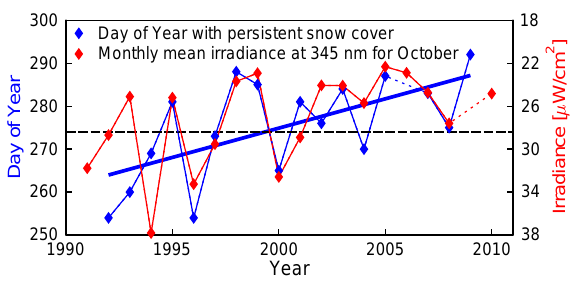
Fig. 5. Comparison of onset of snow cover and irradiance at Bar- row. Blue symbols, left axis: day of year when surface albedo be- comes larger than 0.6 and stays above 0.6 for the rest of the winter. Heavy blue line: linear regression to this dataset. The date of per- sistent snow cover was not well defined in 2006, and the associated data point is missing (broken blue line). Red symbols, right axis: monthly mean irradiance at 345nm for October. Note that the right axis is reversed. No data are available for 2009 (broken red line). The broken black line indicates 1